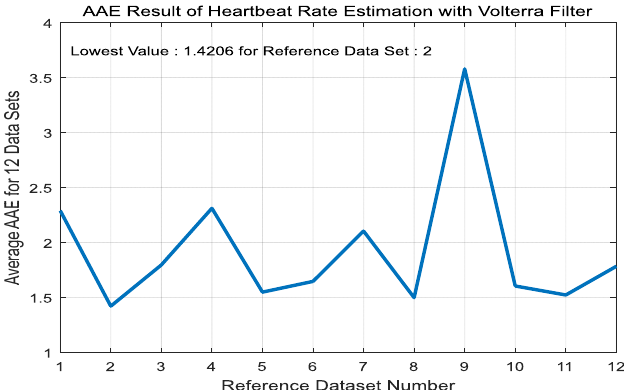
Figure 6. Average AAE’s of the Volterra filters in Table 4 over the total datasets for LOOCV